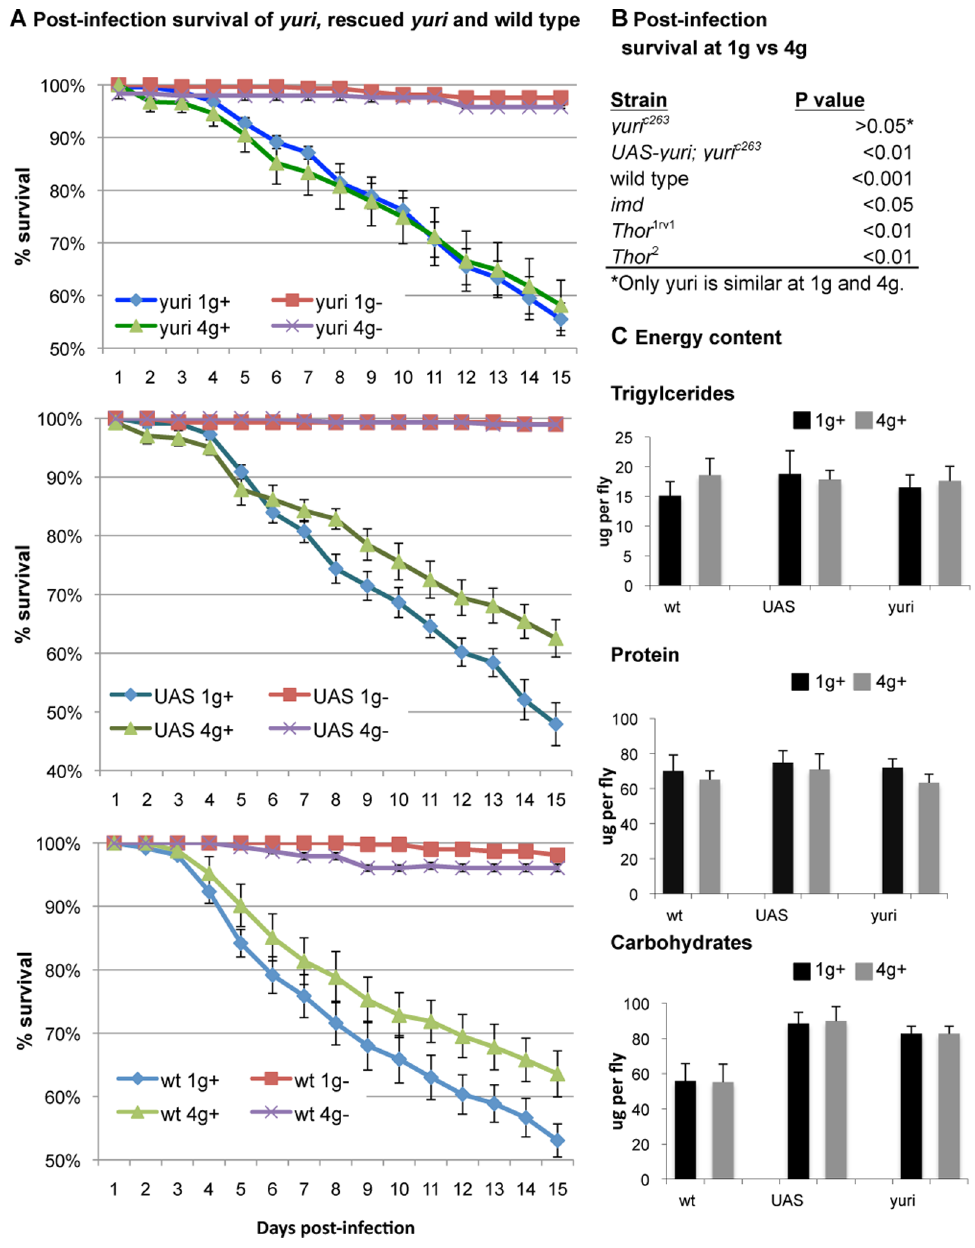
Figure 1. Effects of hyper g on post-infection survival and energy stores. A. Survival after infection with B. bassiana is increased by exposure to hyper g (4 g) in wild type (wt) and the rescued yuri strain, yuri c263 ; UAS- yuri (UAS), but not in the gravitaxis mutant yuri , yuri c263 ( yuri ). + infected, 2 uninfected. Error bars=SEM for 3 experiments. B. Additional strains tested also survive infection longer at hyper g: imd , using imd 1 , and for Thor , which encodes the Drosophila translational regulator 4E-BP, using Thor 2 , the null allele, and its control, the revertant strain Thor 1rev1 . P values for log rank. C. Post-infection energy stores of trigycerides, protein and carbohydrates are not significantly different at hyper g. Error bars=SEM for 3 experiments. humoral immunity in response to Toll and Imd mediated fungal and bacterial infections through transcriptional profiling after development in space. The uninfected space flies showed an altered transcriptional profile, and those changes will be presented last, in the context of the immune response data.